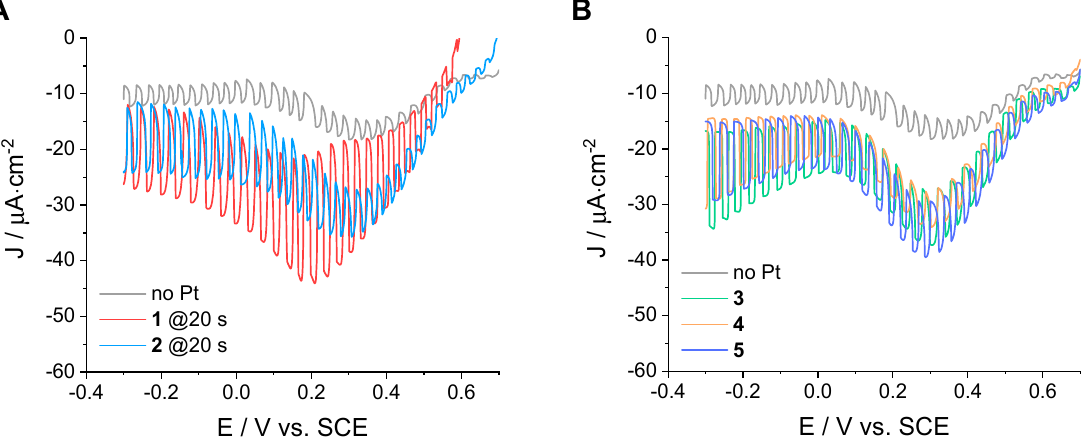
Figure 5. LSV of sensitized electrodes ( A ) NiO-B| P1 |Pt- 1 and NiO-B| P1 |Pt- 2 at 20 s deposition time and ( B ) NiO-B| P1 |Pt- 3 – 5 in N 2 -purged 0.1 M acetate buffer at pH 4 under chopped irradiation (in every graph, a comparison is made with the blank non-platinized electrode, grey trace).